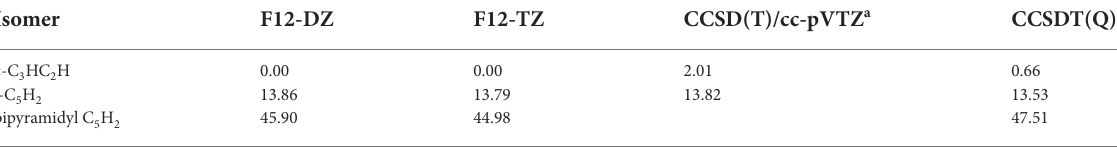
TABLE 1 RelativeenergyofC 5 H 2 Isomersinkcal mol −1 comparedtopreviousexperiment. Isomer